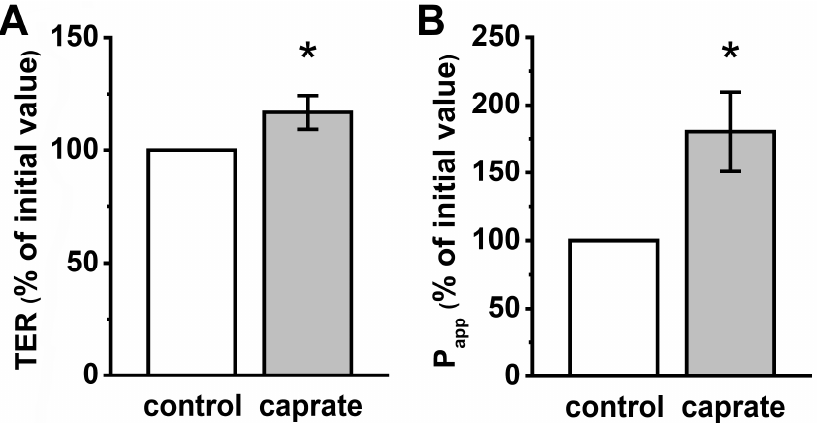
Figure 2 . ( A ) Transepithelial electrical resistance (TER) and ( B ) apparent permeability (P app ) of the paracellular flux marker fluorescein in porcine Peyer’s patches (PP). 5 mM caprate lead to markedly higher TER values (* p < 0.05, n = 11–12), and increased permeability for fluorescein ( n = 8, * p < 0.05).